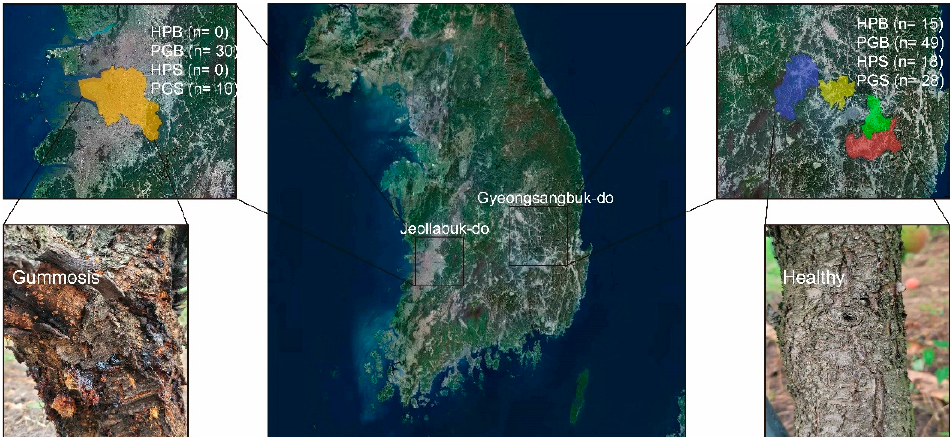
Figure 5. Geographical locations selected in this study. The number of bark and soil samples collected from the two provinces is displayed. Representative healthy bark and gummosis-infected bark are further